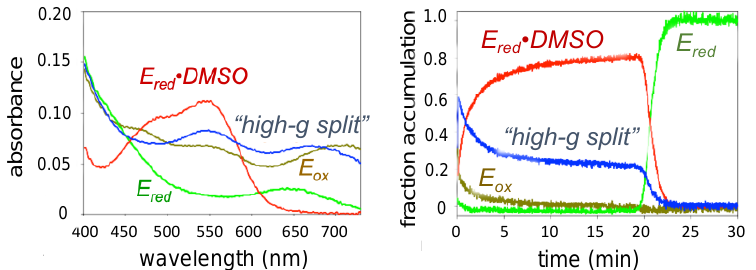
Figure 2. UV/visible absorption spectra of catalytic intermediates for DMSO reductase ( left ) and their time courses ( right ) seen in the course of turnover with DMSO as substrate. E ox , the Mo(V) species giving rise to the “high - g split” EPR signal, E red and E red •DMSO are color -coded for clarity.